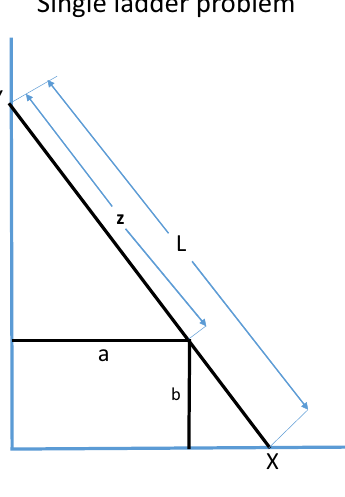
Figure 1. The single ladder problem